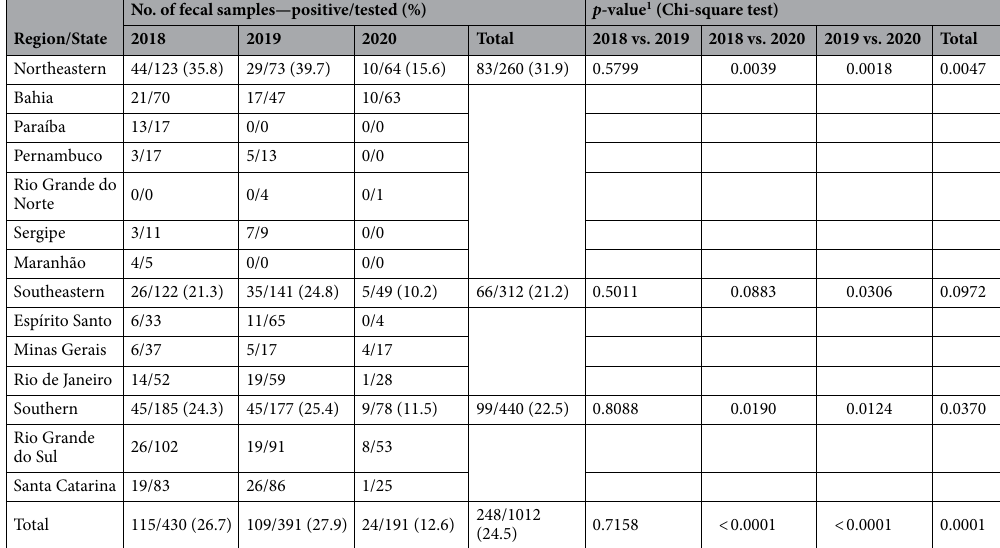
Table 1. Number of HAdV-positive fecal samples identify through laboratory-based surveillance by region and state in Brazil from 2018 to 2020, among rotavirus- and norovirus- negative samples. 1 p -values were calculated by comparing the frequency of HAdV detection between the three years of the study (Total) and between each year for each